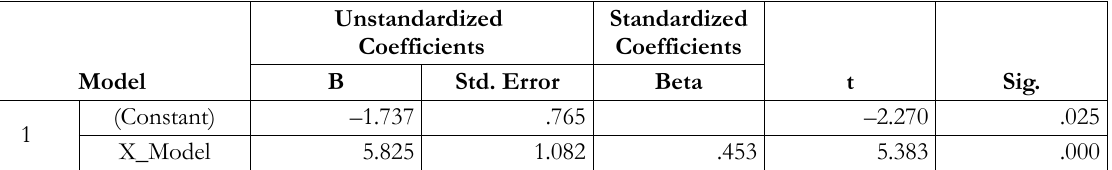
Table 7. The Linear Regression Test Result